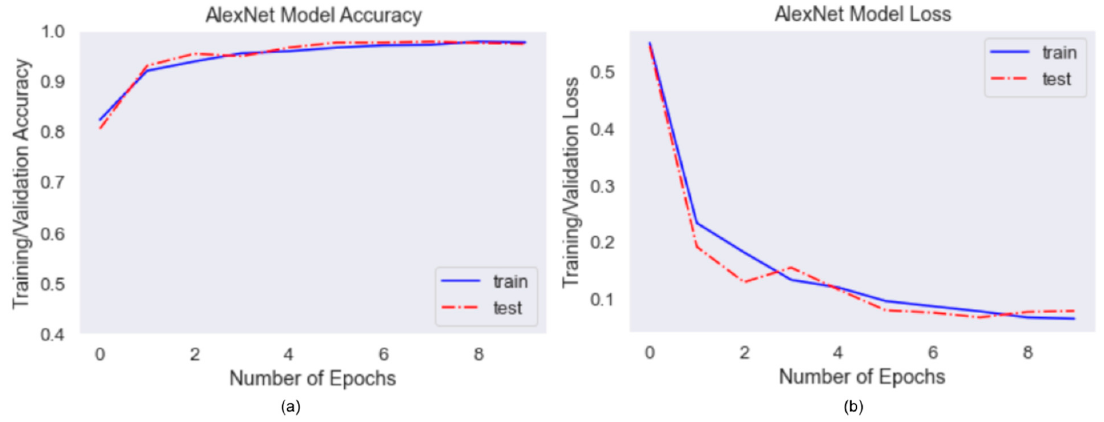
Figure 10. ( a ) AlexNet Accuracy Curve, ( b ) AlexNet Loss Curve.